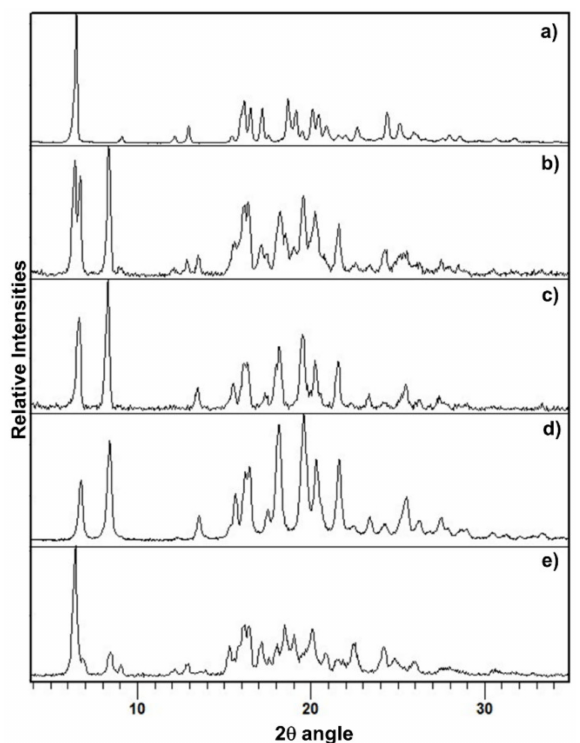
Figure 11. PZQ-HH progressive transformation to Form B at room temperature (from top to bottom): ( a ) fresh sample, ( b ) after 4 months, ( c ) after 12 months, ( d ) Form B, and ( e ) PZQ-HH ground for 30 min at 25 Hz.